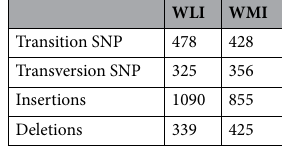
Table 1. Overview of the number of variants, insertions and deletions in the final selection per